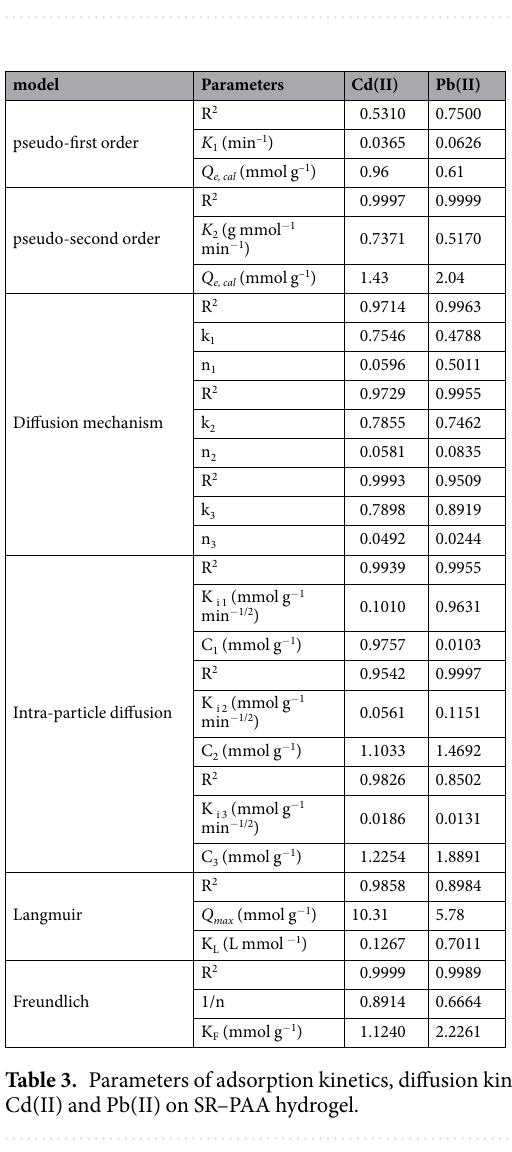
Table 2. Thermodynamic parameters of Cd(II) and Pb(II) ions adsorption on SR–PAA.